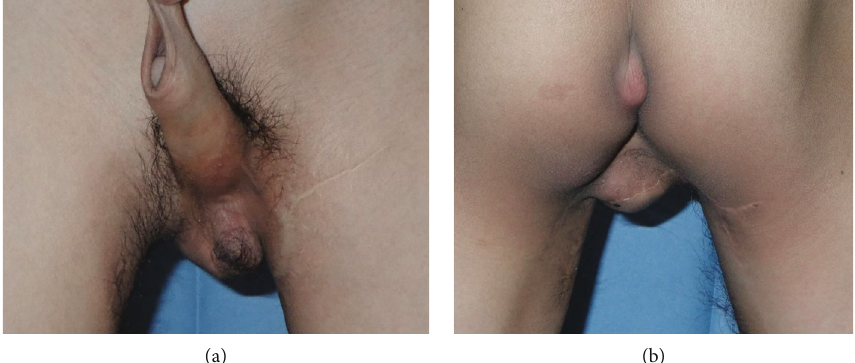
Figure 5: Case 2, eleven years after reconstruction surgery. (a) Anterior view of the scrotum. (b) Posterior view of the scrotum.